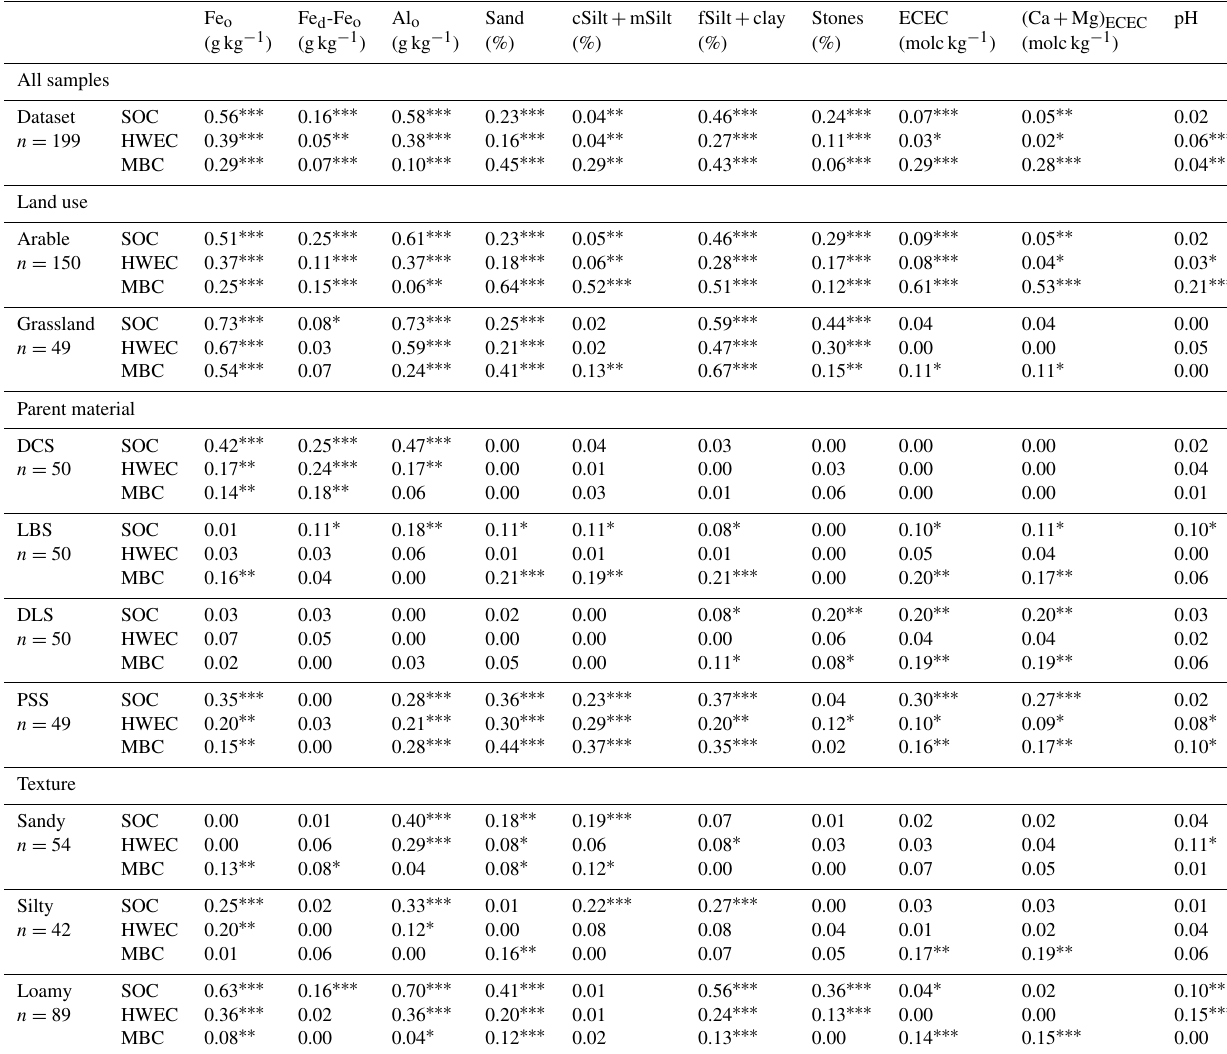
Table 3. Bivariate linear regression coefficient R 2 for parameters explaining the variance of SOC (%), HWEC and MBC (µgkg − 1 ), respec- tively, for soils groups of different parent material, major textural class and land